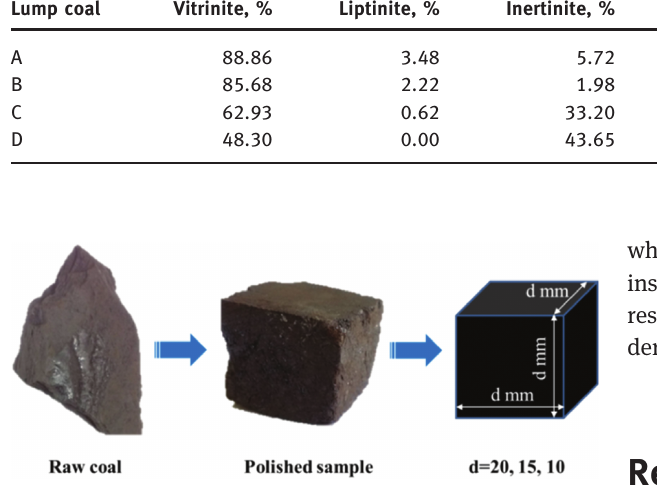
Table 3: Results of the maceral content and maximum vitrinite reflectance. Lump coal